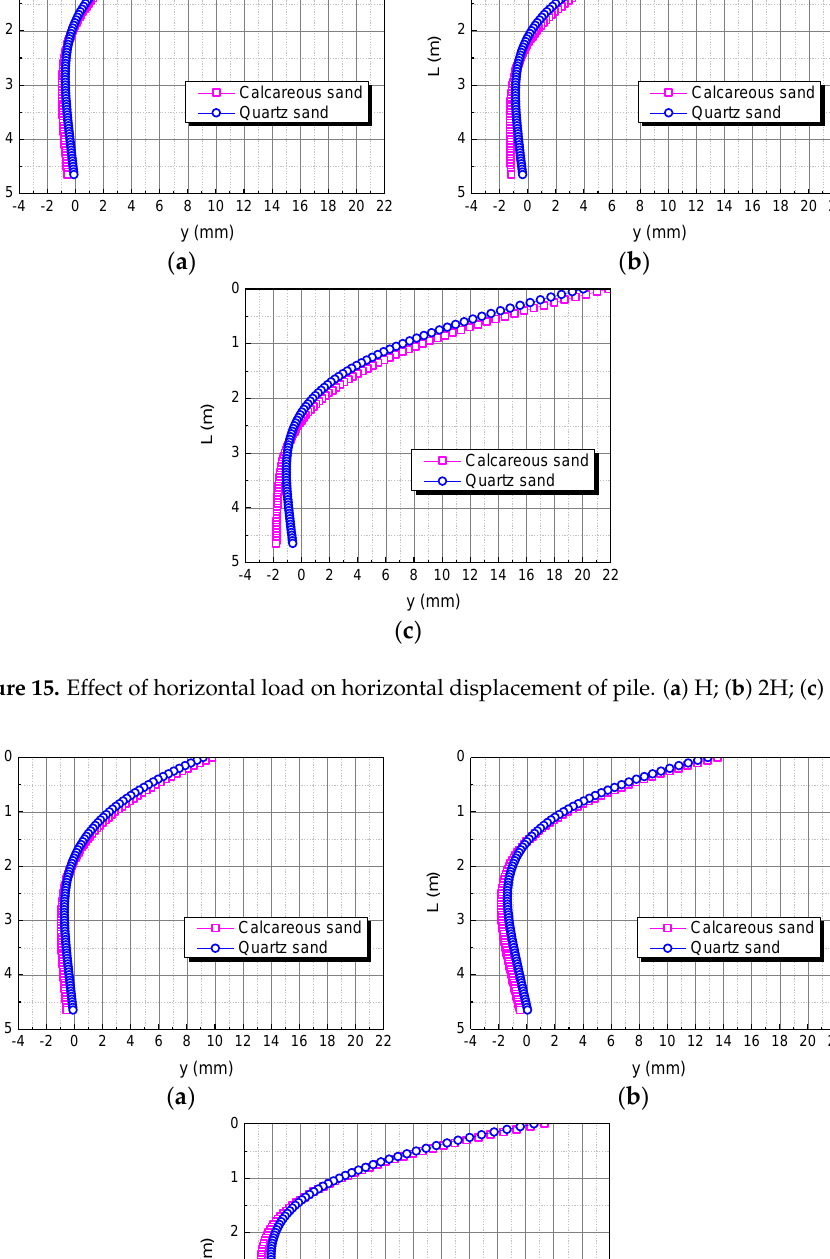
Figure 16. Effect of bending moment on horizontal displacement of pile. ( a ) M; ( b ) 2M; ( c ) 3M. 4.6. Comparison of Void Ratio in Calcareous Sand and Quartz Sand Area The void ratio is taken as e, 1.1e, and 1.2e, respectively, the adopted void ratio e of calcareous sand is 0.998 and that of quartz sand is 0.4, corresponding to an identical rel- ative density of 80%. The influence of the void ratio on the horizontal displacement of the pile body is shown in Figure 17. When the void ratio is e, the horizontal displace- ment of the pile top in the calcareous sand area is 0.63122 mm larger than in the quartz sand area. When the void ratio is 1.1e, the horizontal displacement of the pile top in the calcareous sand area is 1.77762 mm larger than in the quartz sand area. When the void ratio is 1.2e, the horizontal displacement of the pile top in the calcareous sand area is 3.1107 mm larger than in the quartz sand area. The greater the void ratio, the greater the difference between the two. This may be due to the fact that calcareous sand is more eas- ily compressed than quartz sand due to the greater void ratio. -4 -2 0 2 4 6 8 10 12 14 16 18 20 22543 2 10 L ( m ) y (mm) Calcareous sand Quartz sand